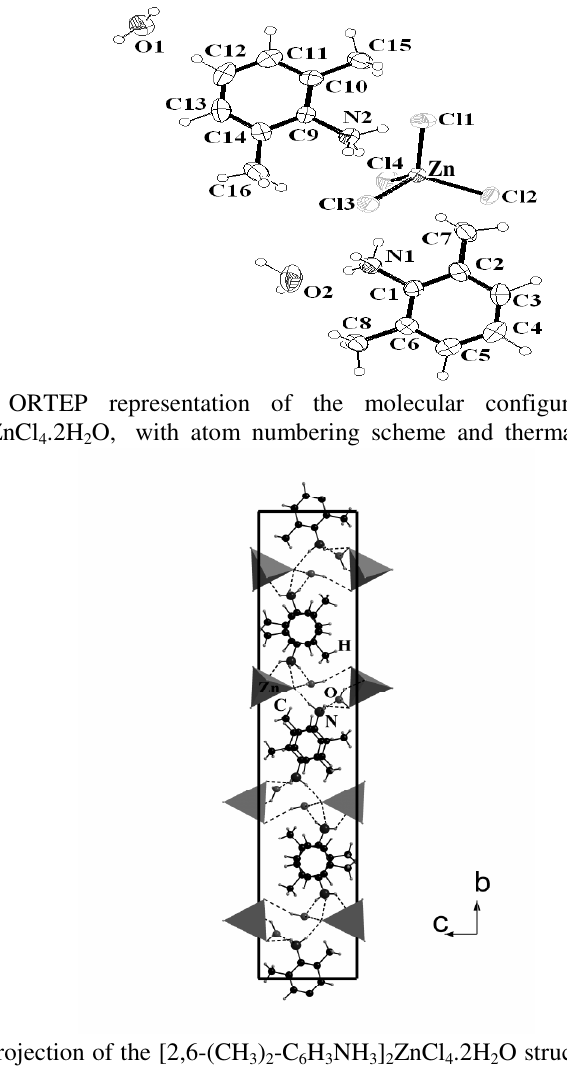
) -C H NH ] ZnCl .2H O structure in the plane (b, c). 3 2 6 3 3 2 4 2